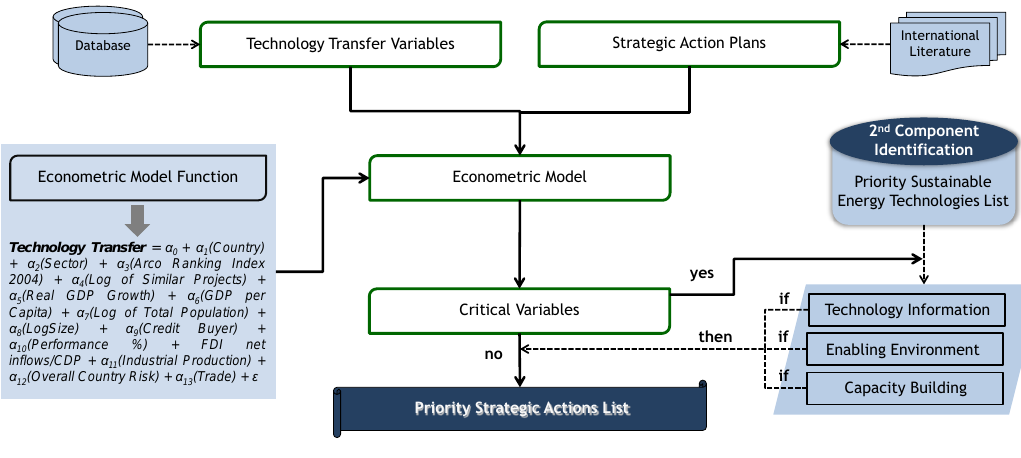
Figure 5. 3rd component—define.